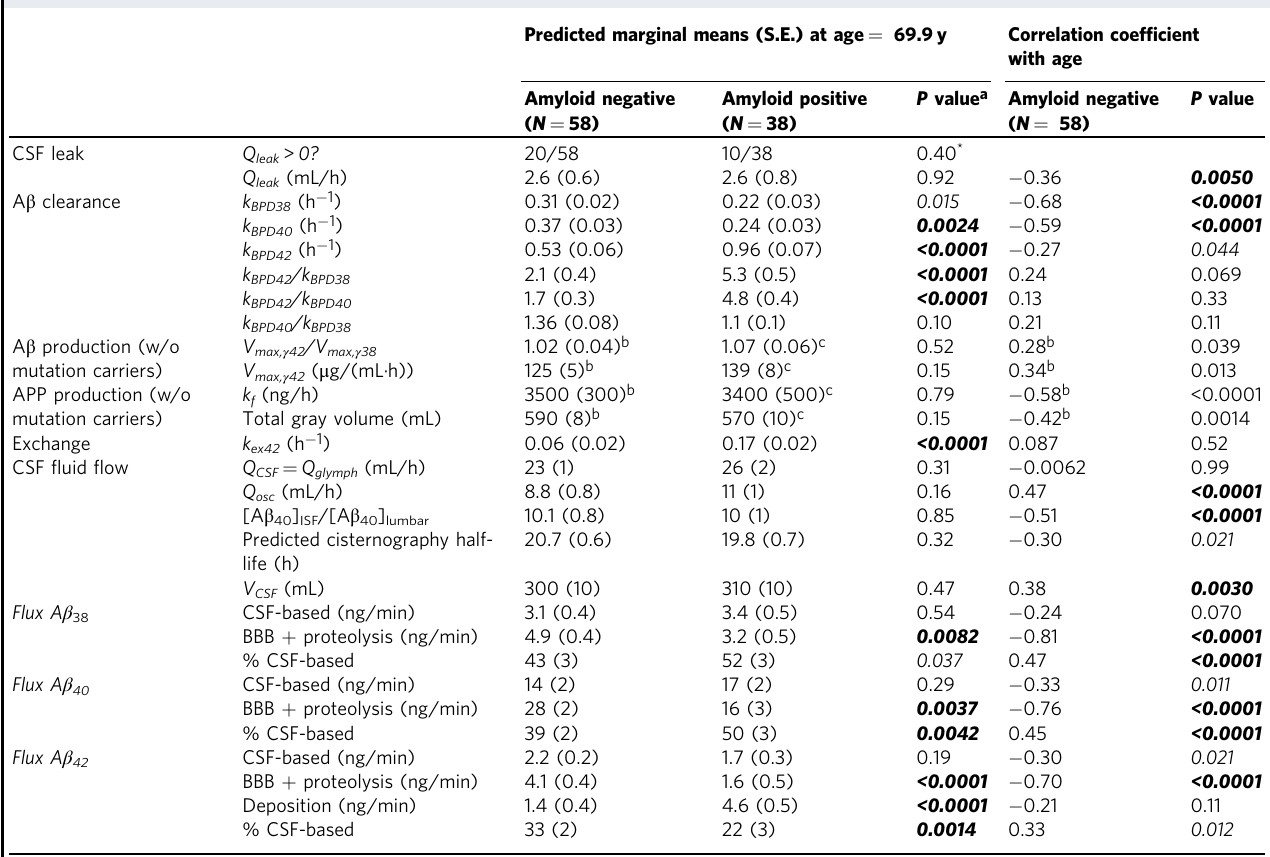
* Chi-square statistic = 0.71. a t test of predicted marginal means (least-squares means) except where noted by *. See Supplementary Table 5 for interactions between age and amyloid status; italic values signify: P <0.05; bold italic values signify: P <0.01. b N = 54. c N =